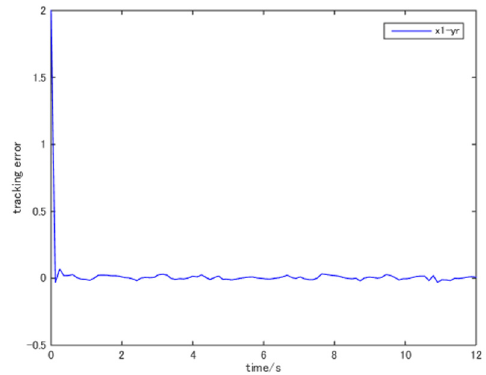
Figure 2. The trajectory of x 1 ( t ) − y r ( t ) .